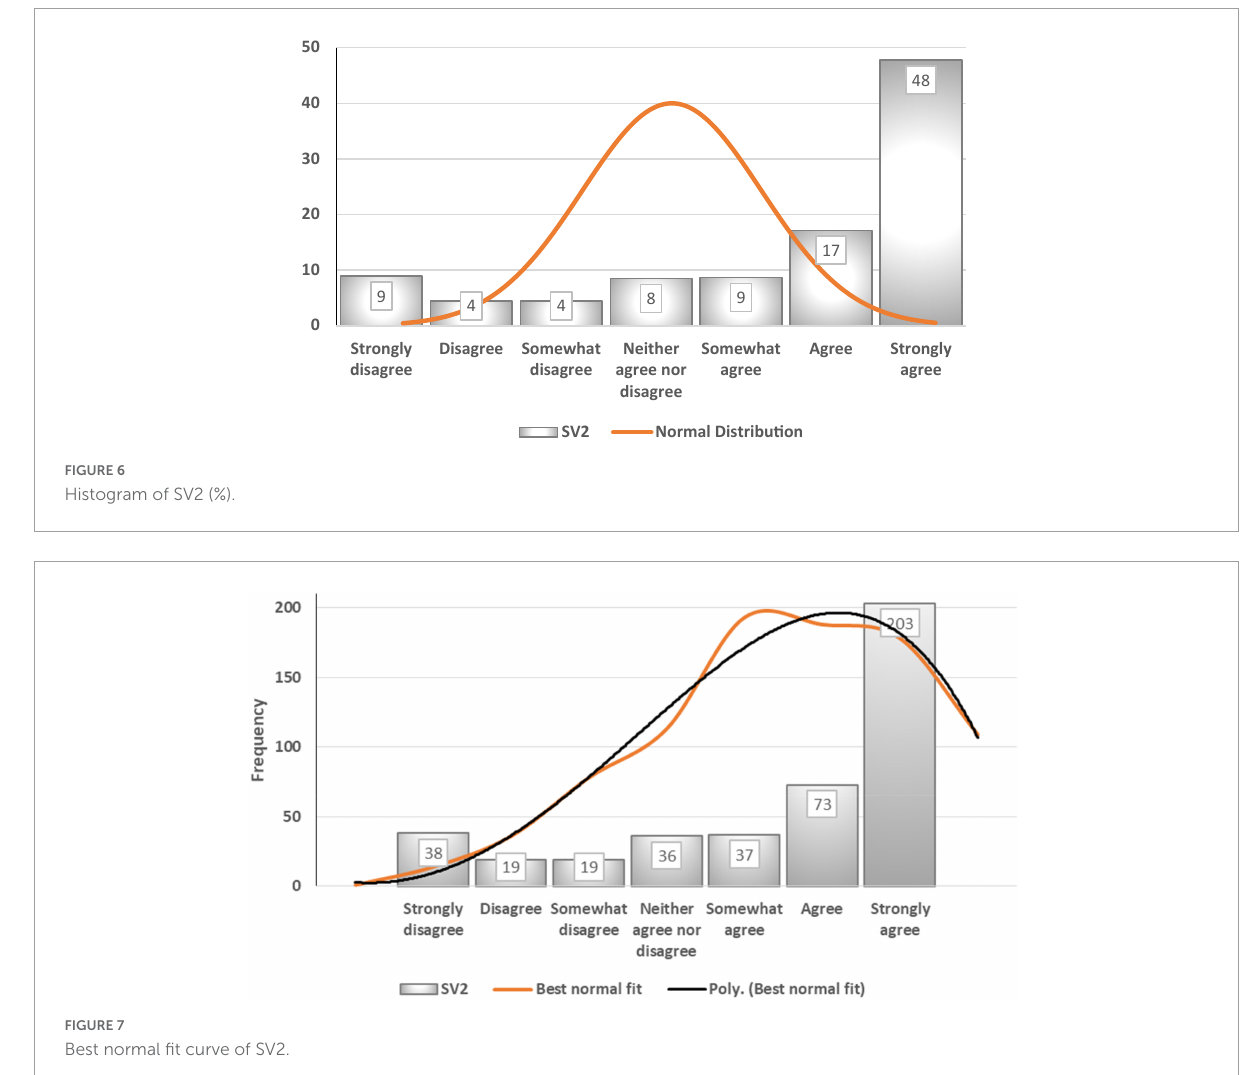
FIGURE7 Best normal fit curve of